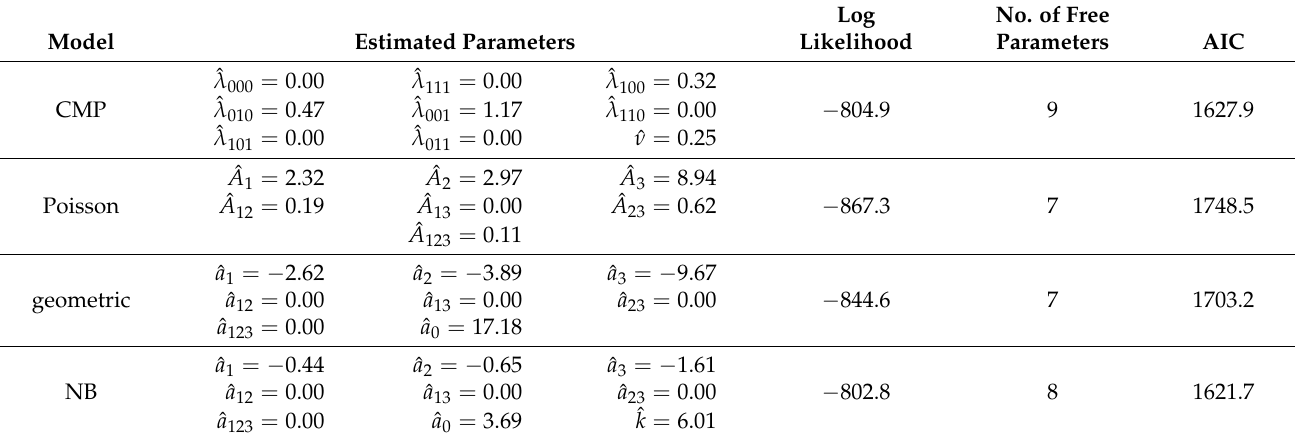
Table 4. Estimation results associated with the Corporación Favorita grocery sales data based on various assumed trivariate models: Conway–Maxwell–Poisson (CMP), trivariate Poisson, trivariate geometric and trivariate negative binomial (NB). Respective log-likelihood and Akaike Information Criterion (AIC) values are also provided, along with the number of free parameters for AIC